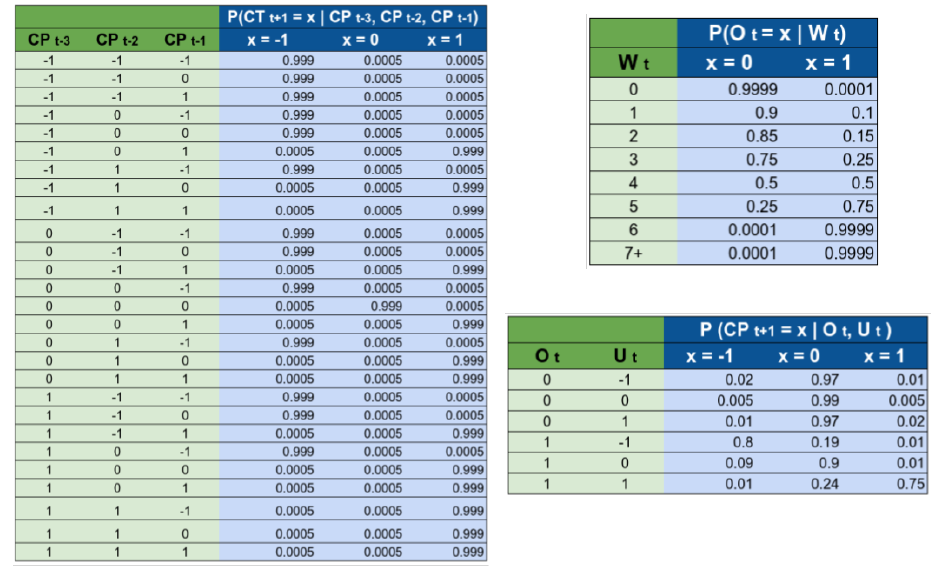
Figure 4. Conditional probability tables used by SIMLR. The names of the variables refer to the nodes that appear on Figure 2 on the main